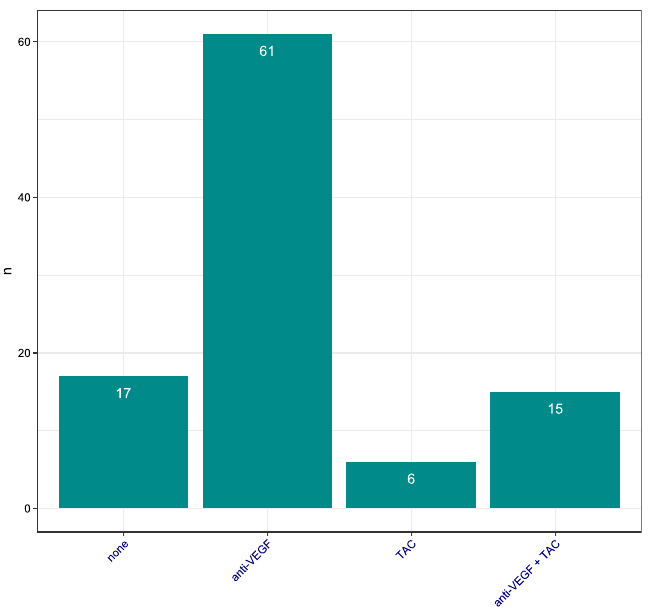
Figure 1. Pre-treatment status at baseline. The majority of eyes had pre-treatment with either anti-VEGF, triamcinolone (TAC) or both. Only 17 eyes (17%) received DII as first-line